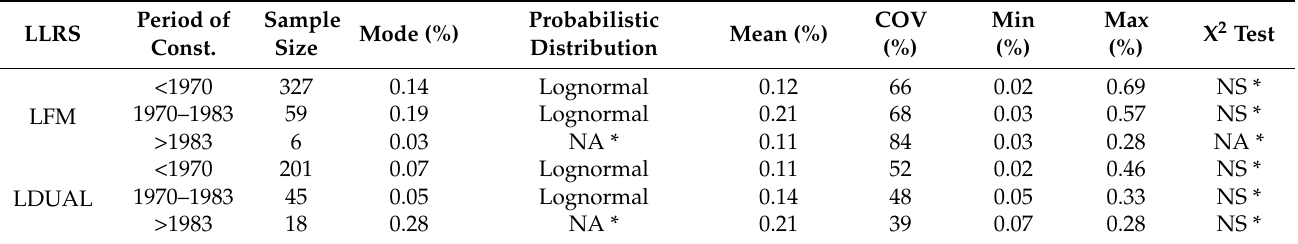
Table 11. Probabilistic distribution of RC columns (cid:48) transverse reinforcement ratio ( ρ w ) in function of the lateral load resisting system (LLRS) and period of construction.